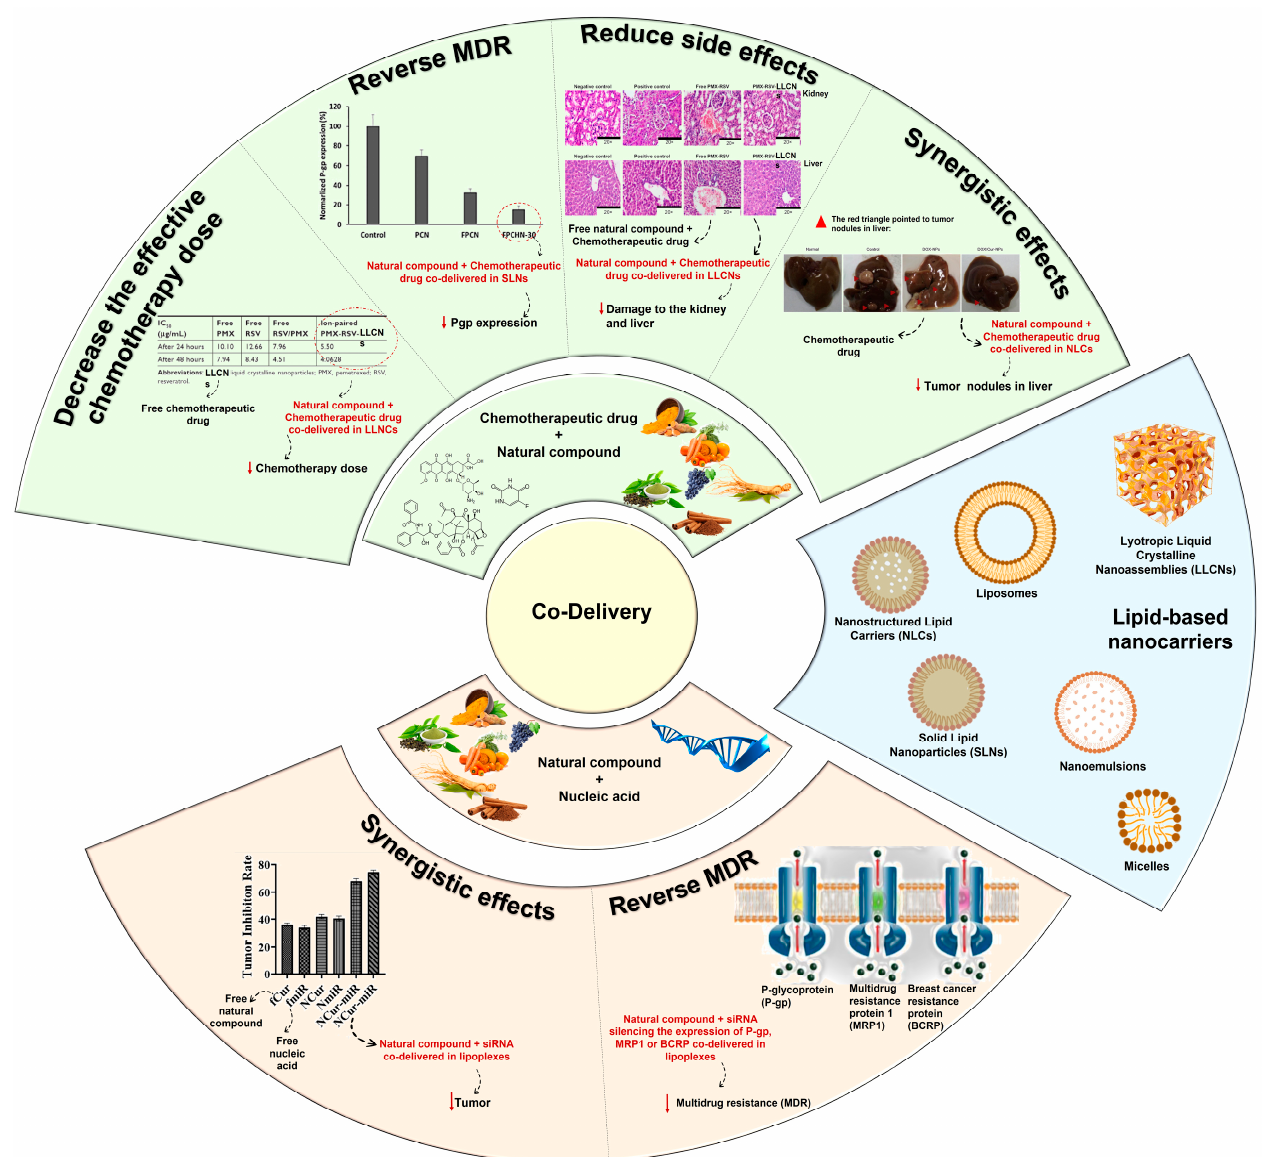
Figure 2. Schematic illustration of lipid-based nanocarriers and advantages of their use for the co- delivery of natural compounds and chemotherapeutic drugs or nucleic acids. Adapted from [36,37], and from [38,39] with permission from